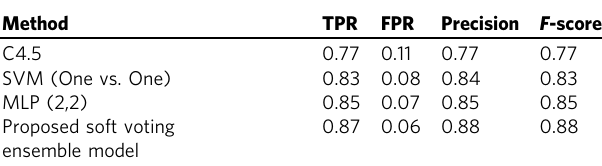
Table 6 Comparative classi fi cation performance of proposed soft voting ensemble model in terms of TPR, FPR, Precision, and F -score.